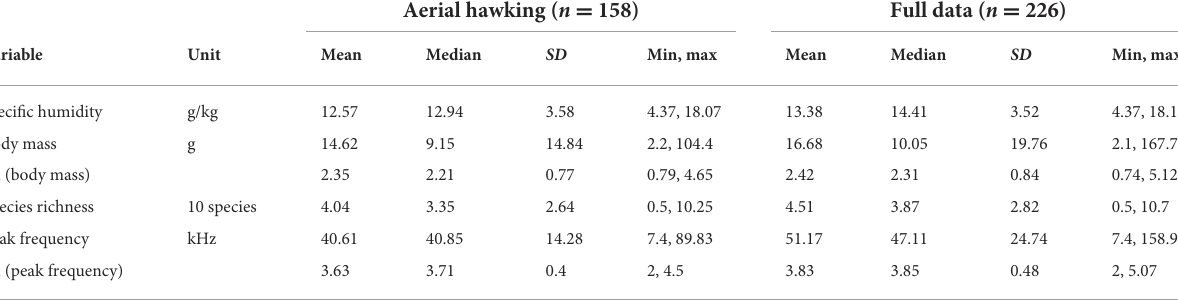
TABLE 1 Descriptive statistics for the variables used in this study: both raw scale and natural logarithm (ln) transformations are shown for peak frequency and body mass. Aerial hawking ( n =